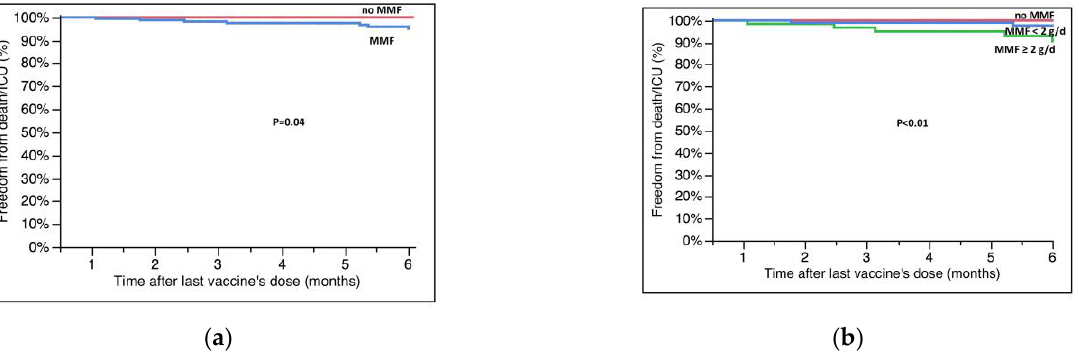
Figure 3. Survival free from hospitalization in the ICU/death at six months after the last dose of vaccine according to ( a ) MMF therapy and ( b ) dose of MMF (at the moment of vaccination in both cases). Survival rates are reported in the text; g/d = grams/day.